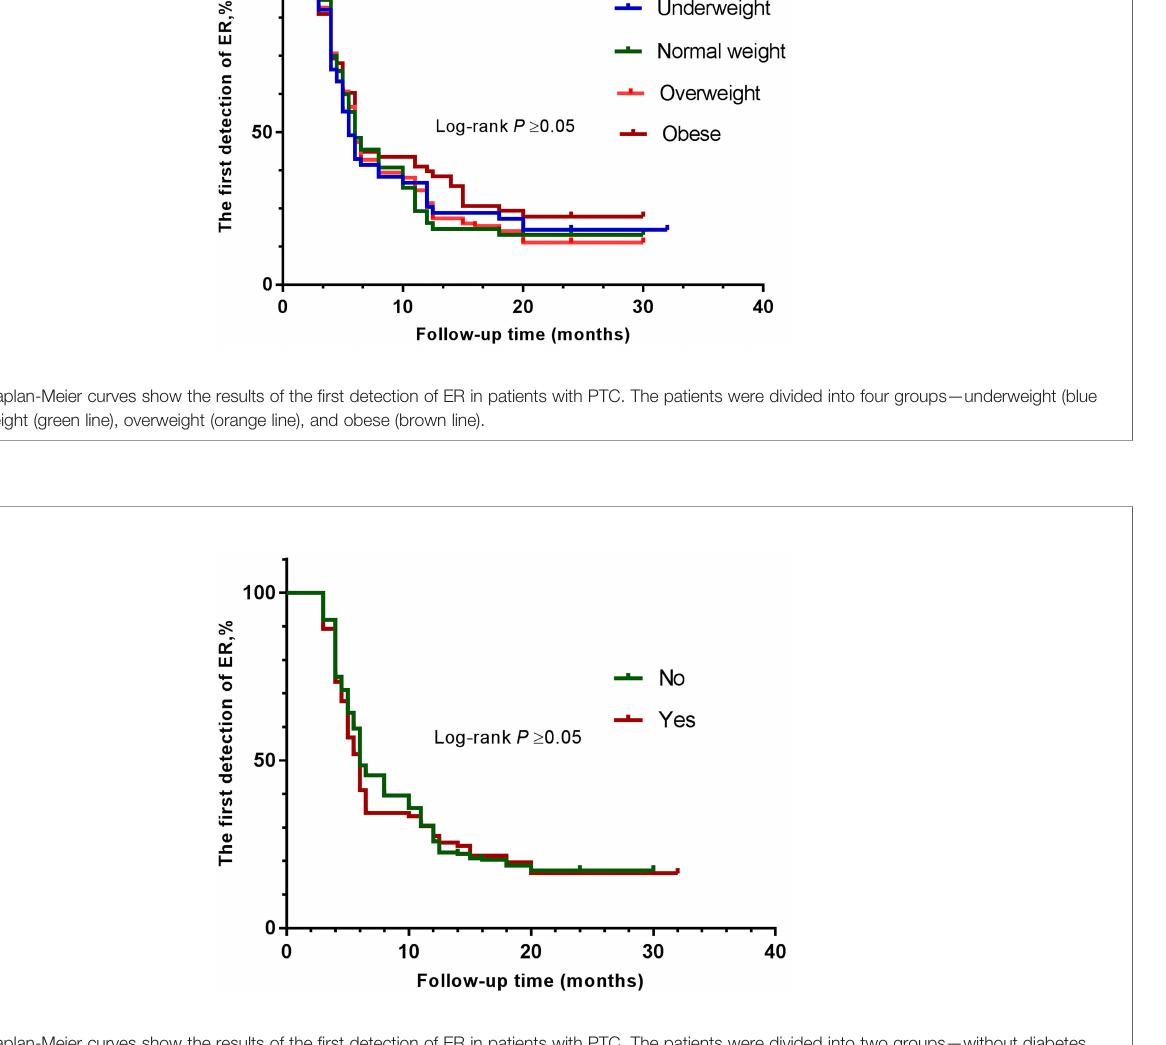
FIGURE 2 | Kaplan-Meier curves show the results of the fi rst detection of ER in patients with PTC. The patients were divided into two groups — without diabetes (green line), and with diabetes (brown